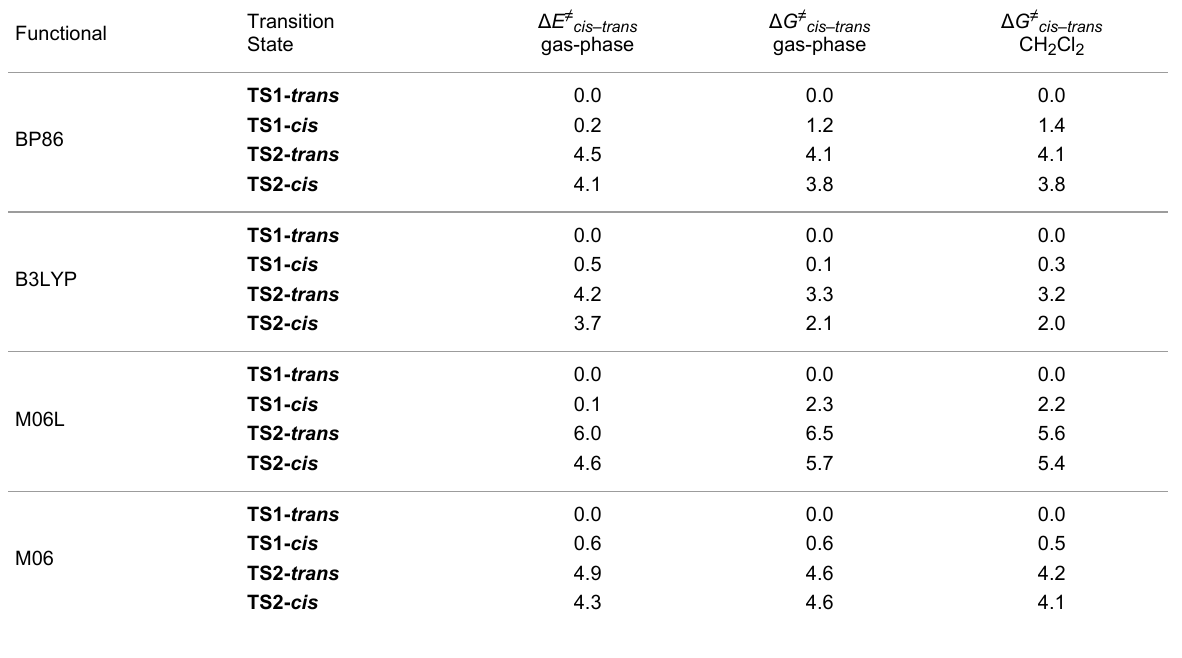
Table 1: Energy difference, in kcal·mol -1 , between the cis and trans transition states TS1 and TS2 of Figure 1, calculated with different computational approaches. In all cases TS1- trans is taken as reference at 0 kcal·mol − 1 .